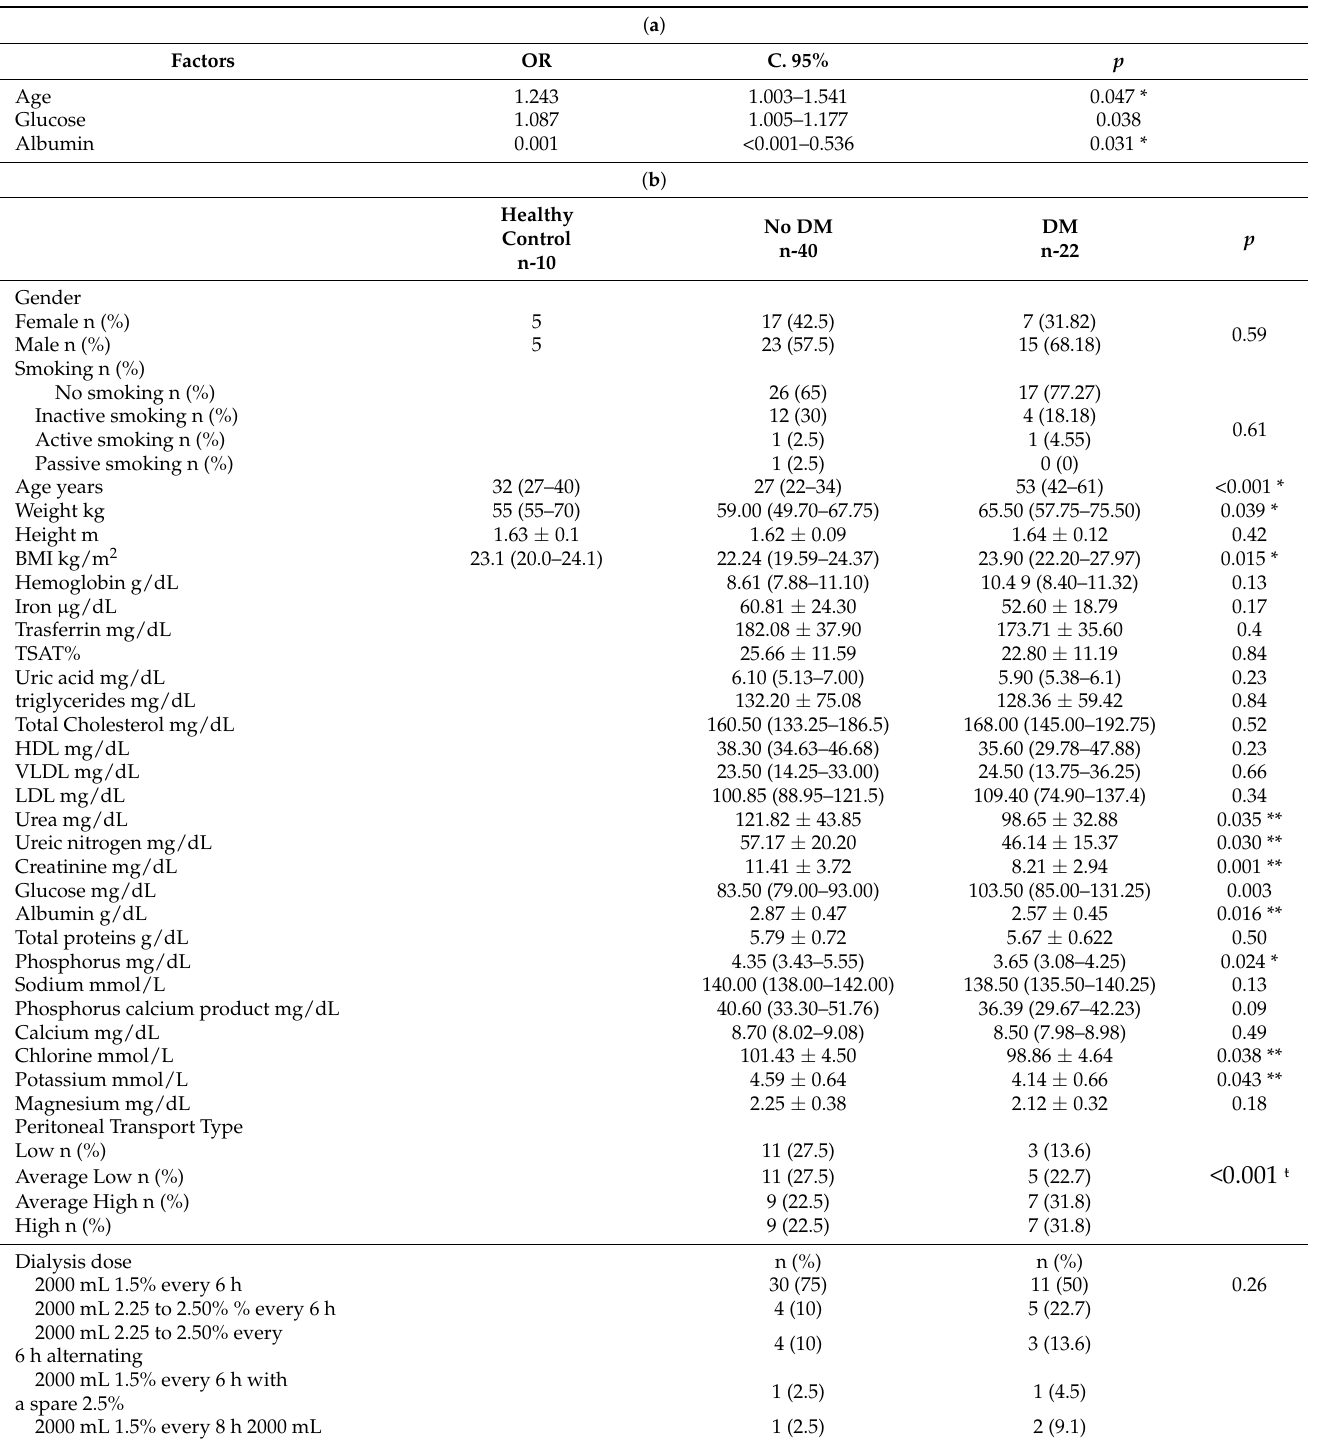
Table 1. (a) Factors associated with type 2 DM in patients on PD in the multivariate model; (b) Demographic and biochemical data of patients on PD with type 2 DM.